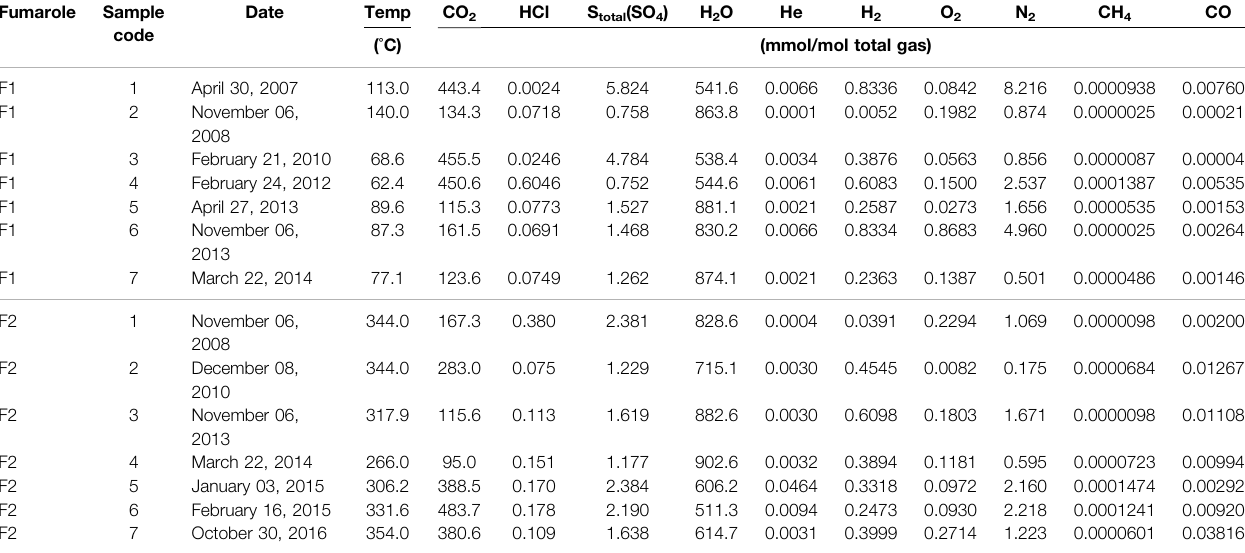
TABLE 1 | Outlet temperatures (in degree Celsius) and chemical composition (dry gas fraction in mmol/mol total gas) of fumarolic gases from Pico do Fogo volcano. Fumarole Sample